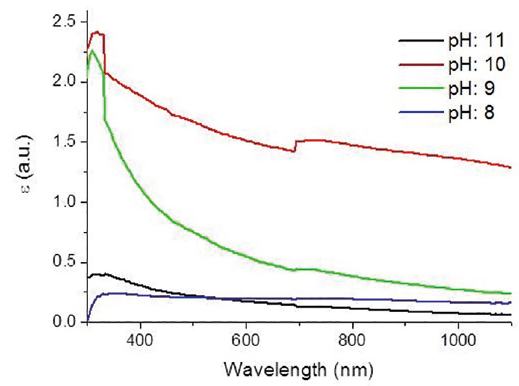
Figure 7. Plot of dielectric constant of MnSeO4 films deposited at various pH levels